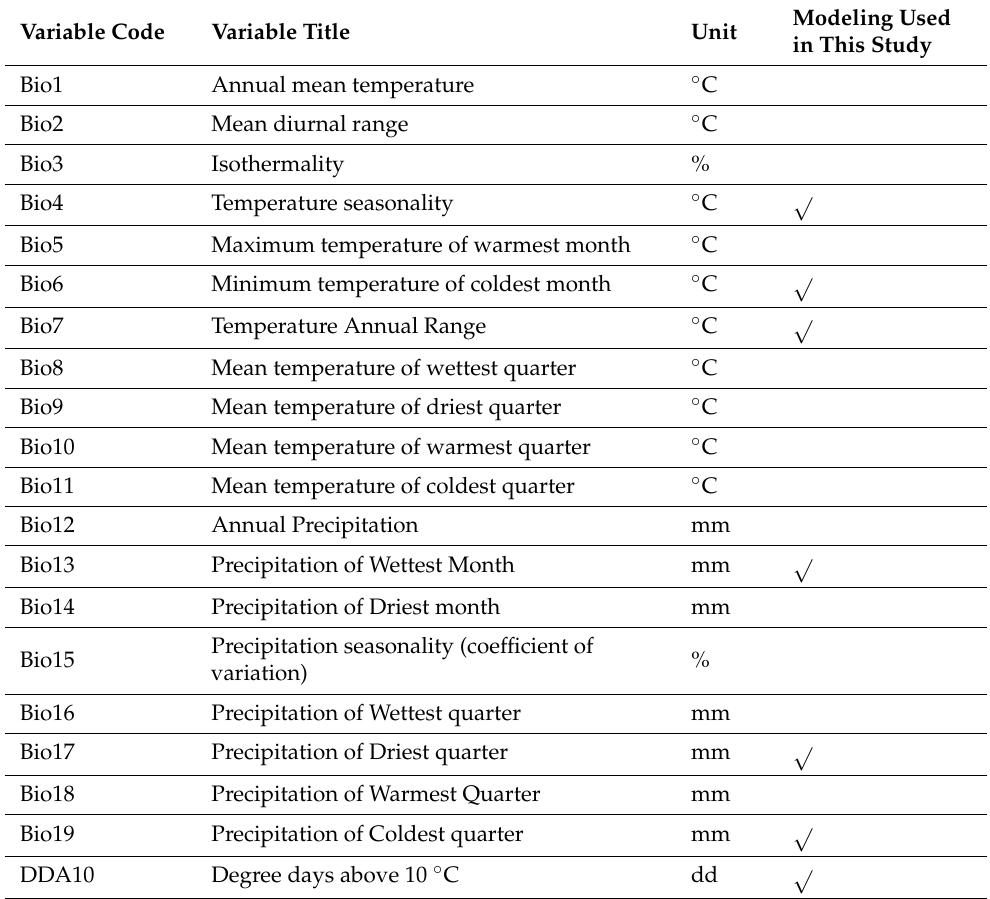
Table 1. Bioclimatic variables from the WorldClim dataset, plus degree days, assessed to determine suitability for inclusion in Thaumatotibia leucotreta predictive modeling. DDA10 is Degree days above 10 ◦